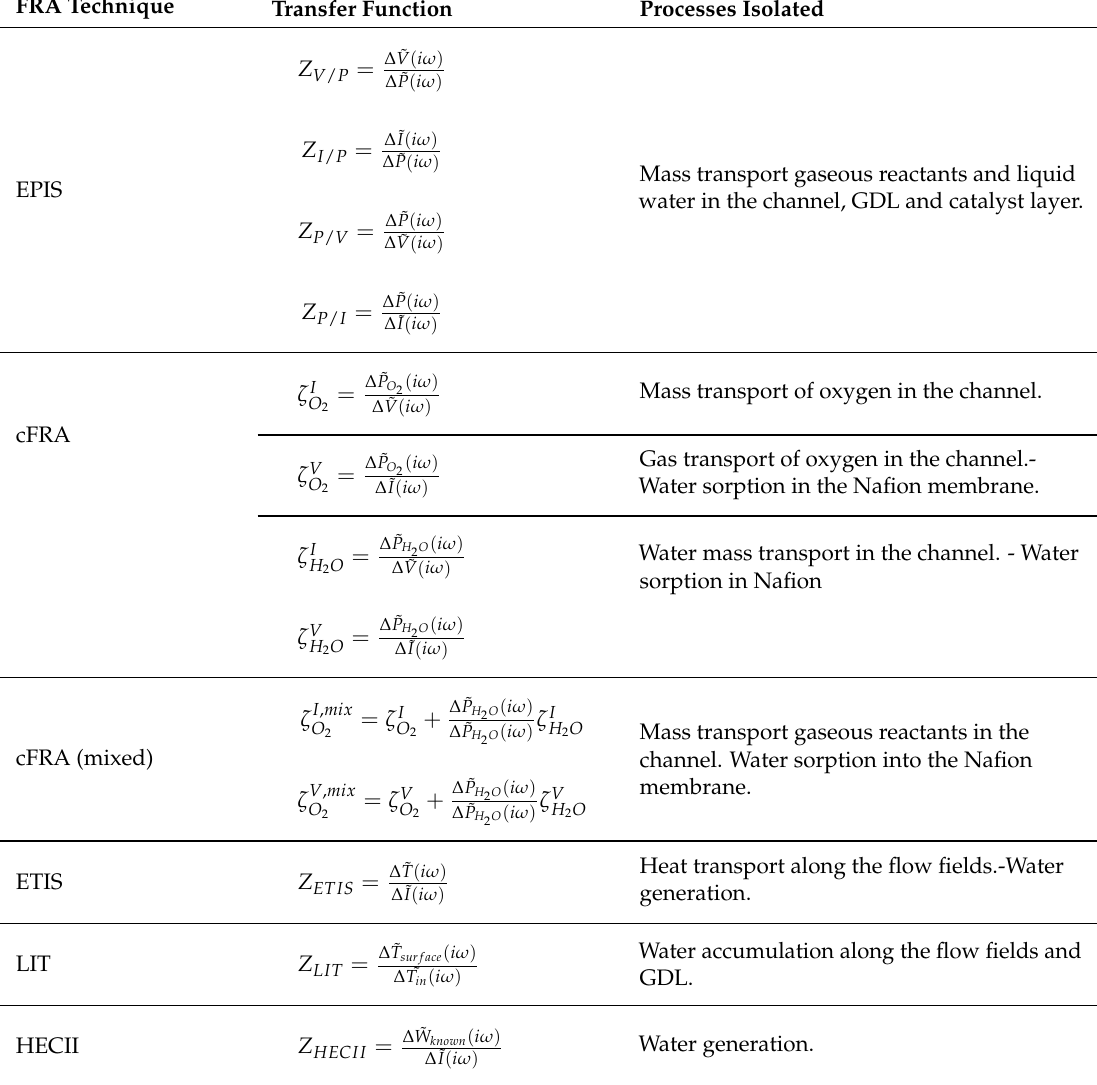
Table 3. A summary of transfer functions based on nonelectrical input or output and main processes isolated by these